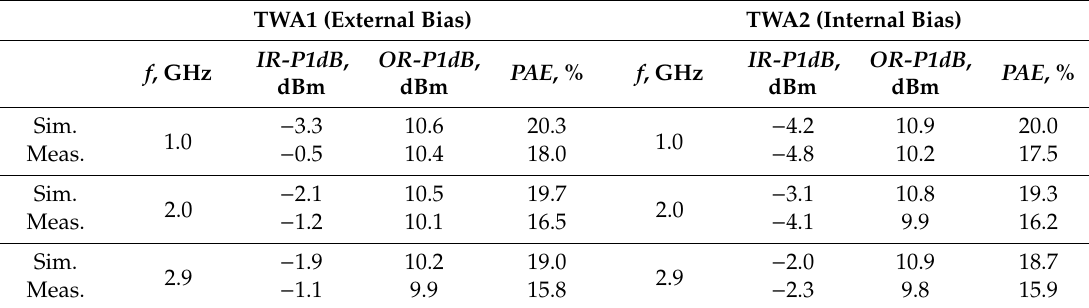
Table 2. Designed TWA output power and e ffi ciency measurement